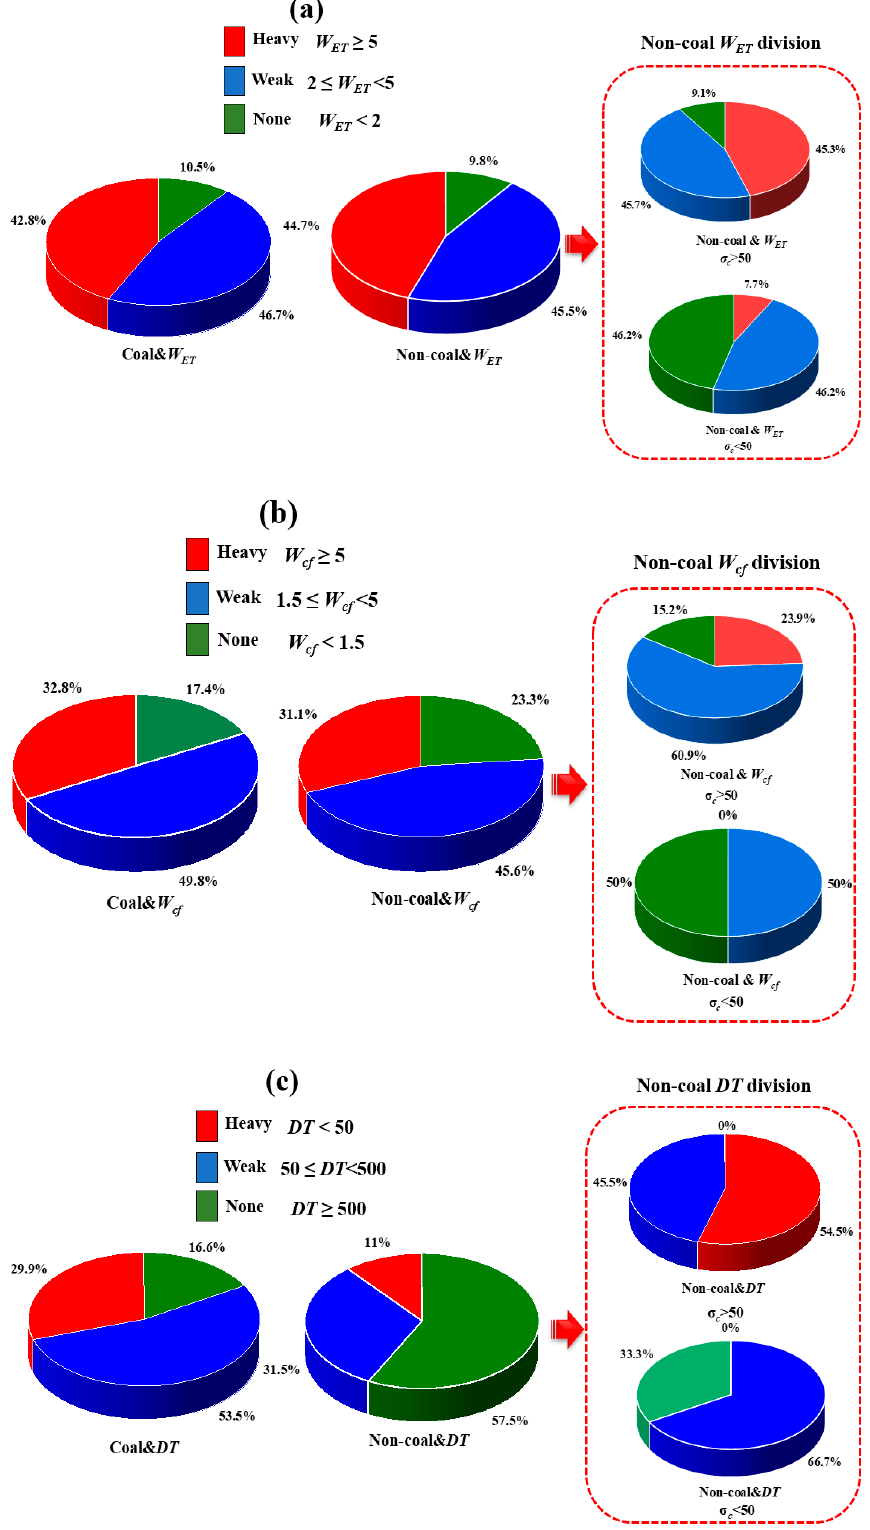
Figure 8. Percentages of coal and non-coal rocks with different bursting liabilities: ( a ) elastic strain energy index W ET , ( b ) bursting energy index W cf , and ( c ) duration of dynamic fracture DT